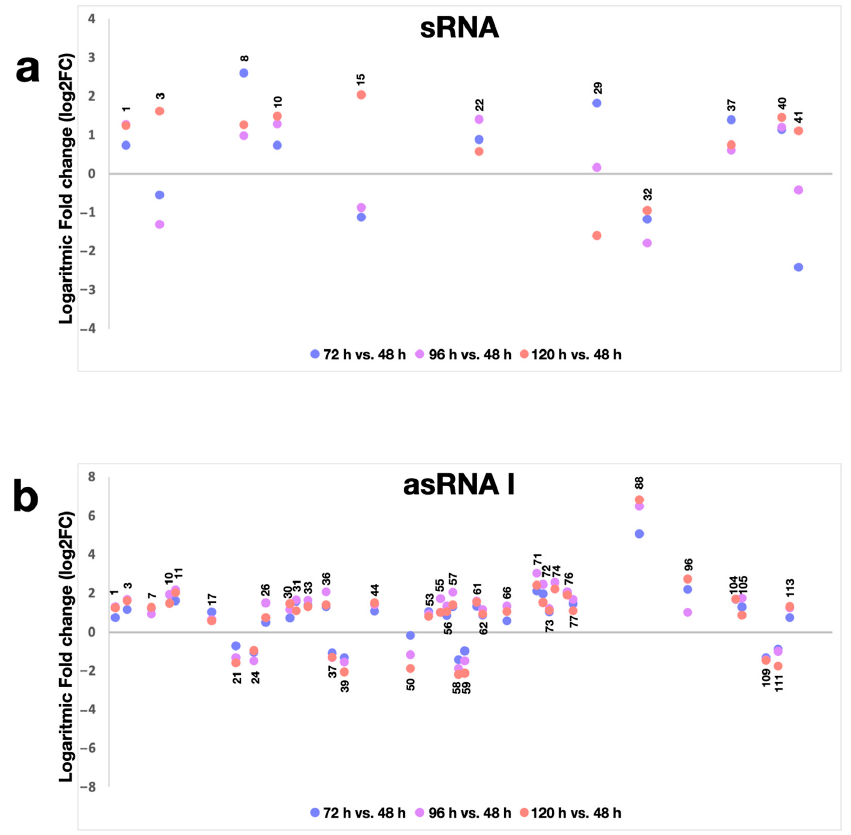
Figure 3. Differential expression of ncRNAs during the growth of S. ambofaciens ATCC 23877. ( a – b ) S. ambofaciens ATCC 23877 was cultivated in YS, and ncRNA levels were determined after 48 h, 72 h, 96 h, and 120 h (Supplementary Table S7). Log2Fold changes of sRNA ( a ) and asRNA I ( b ) result- ing differentially expressed in at least one timepoint were reported. The sRNAs and asRNAs I